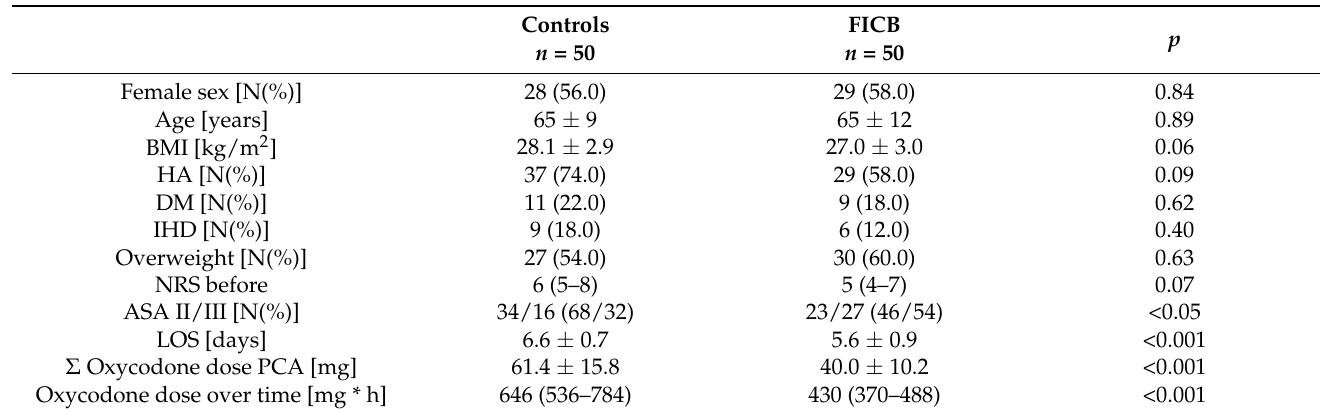
Table 1. Comparison of the evaluated descriptive parameters between the study groups.